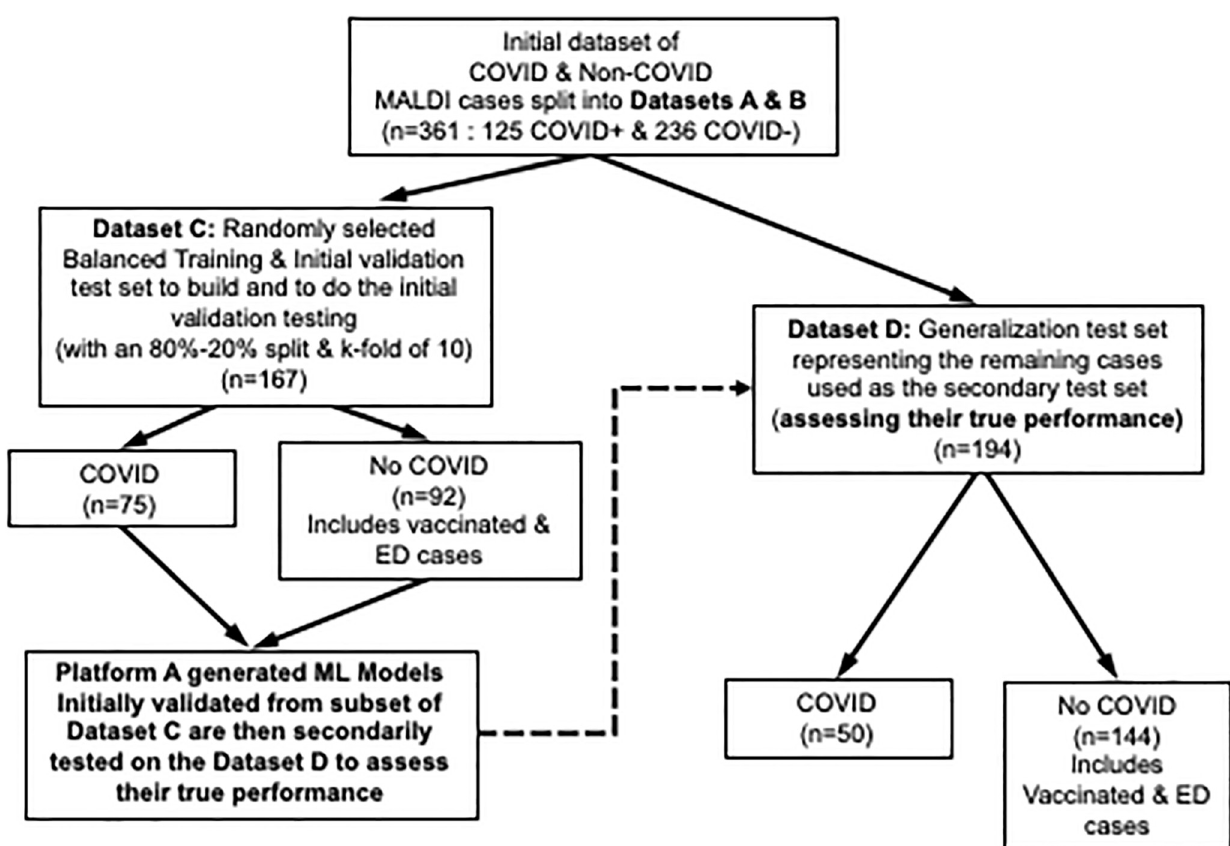
Fig 2. Study datasets. Datasets A and B were obtained from two different time points (before and after COVID-19 vaccine emergency use authorization. Combined, Datasets A and B totaled 361 asymptomatic and symptomatic patients. These data were randomly divided into Datasets C and D, with Dataset C serving as the training/ initial validation dataset. Optimized models produced from Dataset C were then secondarily tested with Dataset D for generalization to assess their true performance. Notably, Dataset C and D both contained random samples of the various negative subgroups (negative vaccinated individuals, emergency department [ED] patients,